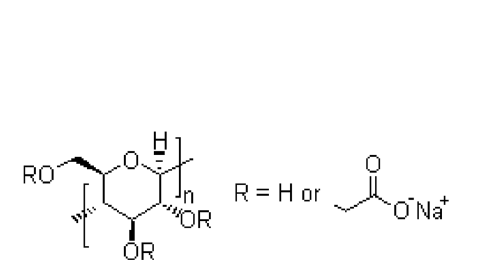
Fig. 1 Molecular structure of carboxymethyl cellulose salt. Adapted from carboxymethyl cellulose sodium (CMC)-oil drilling (https :// www.iroch emica l.com/produ ct/Mud-Drill ing/CMC.htm) Fig. 2 Chemical structure of partially hydrolyzed polyacryla- mide polymer. Adapted from figures–partially hydrolyzed polyacrylamide (PHPA) poly- mer (Sharma